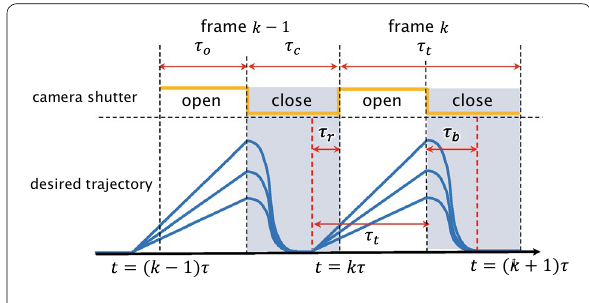
Fig. 5 Frame-by-frame intermittent tracking